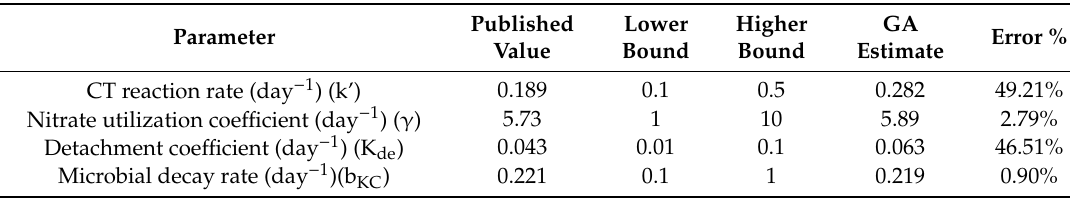
Table 6. Comparison of the PGA-estimated parameters with published parameters along with their bounds for benchmark problem